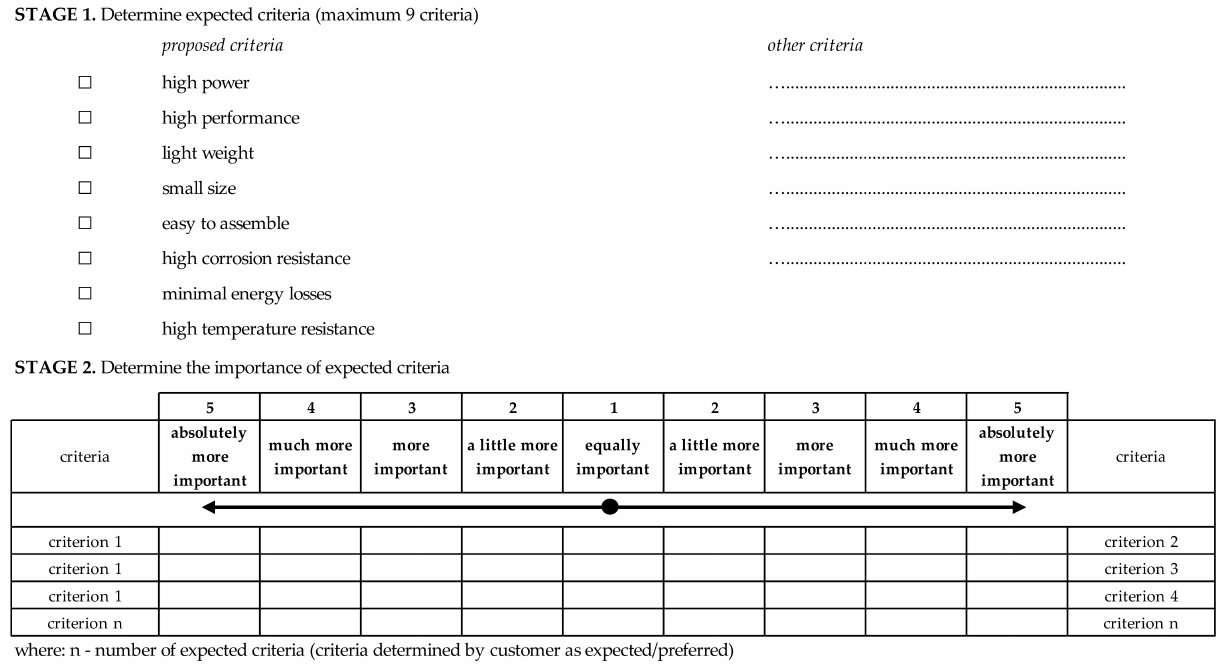
Figure 5. Example of questionnaire to obtain customer expectations. Own